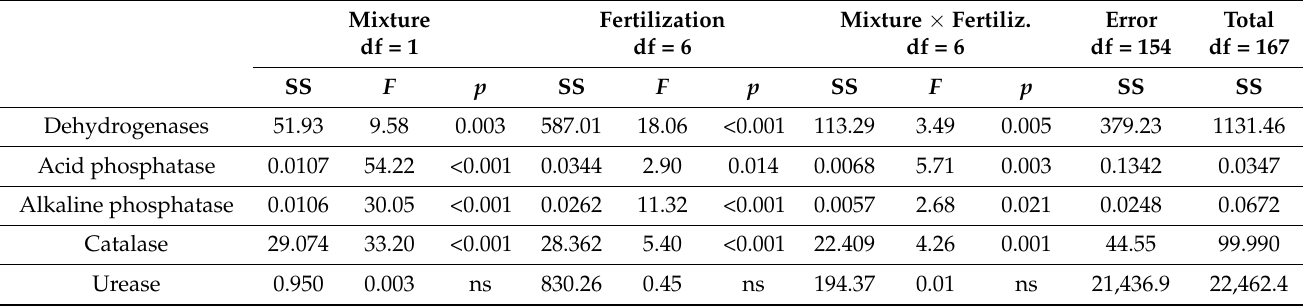
Table 4. Two-way ANOVA analyses of influence of fertilization and plant mixture on enzymes activity in 2018–2019 ( n = 168). Mixture Fertilization Mixture × Fertiliz.